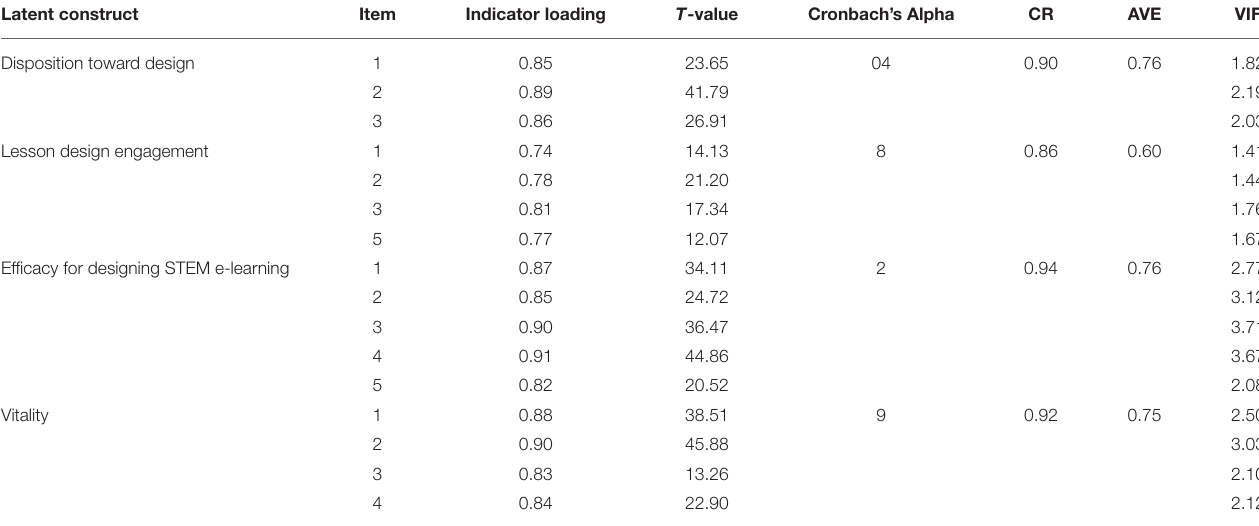
TABLE 1 | Results of the measurement model.